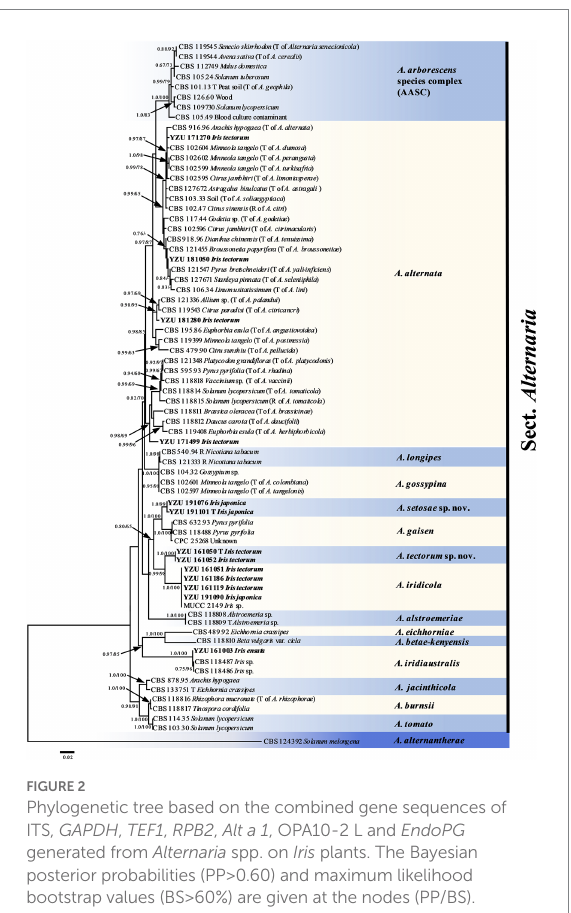
FIGURE 2 Phylogenetic tree based on the combined gene sequences of ITS, GAPDH , TEF1 , RPB2 , Alt a 1 , OPA10-2 L and EndoPG generated from Alternaria spp. on Iris plants. The Bayesian posterior probabilities (PP > 0.60) and maximum likelihood bootstrap values (BS > 60%) are given at the nodes (PP/BS). Examined present strains are in